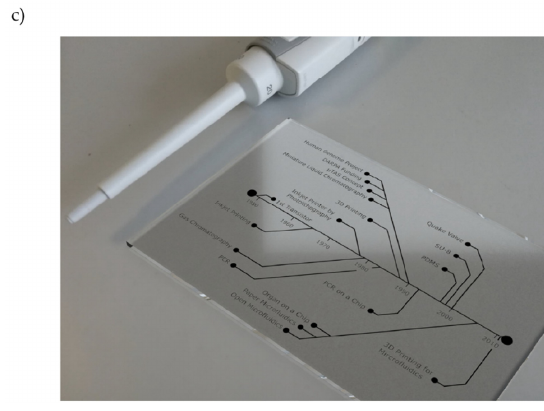
Figure 1. ( a ) Approximate length scales for several biological and micro fabrication structures [50]. ( b ) Photograph of a gas chromatograph integrated on a planar silicon wafer fabricated by Terry and co-workers at Stanford University [59]. ( c ) Timeline highlighting the main advances in the field of microfluidics starting with the invention of the transistor and leading up to the rise in 3D-printed devices [62].